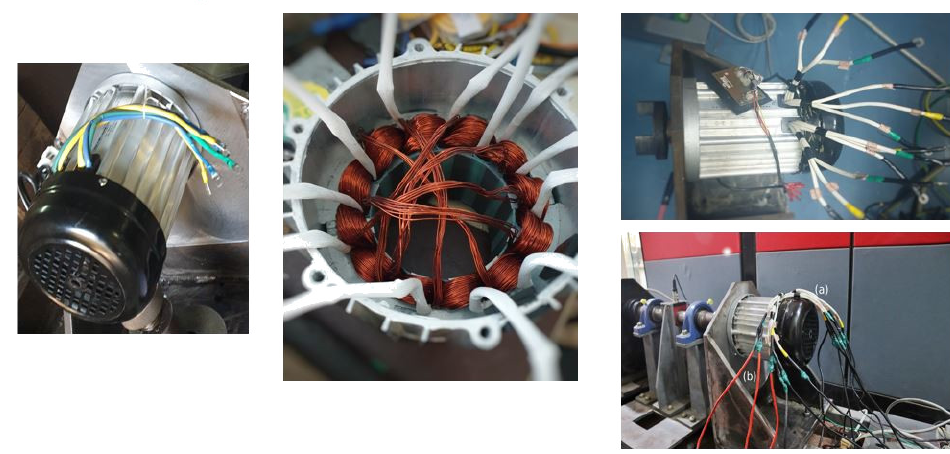
Figure 12. Photograph of rewinding the conventional SRM to HESRM (a) Main winding (b) Auxi- lary winding.